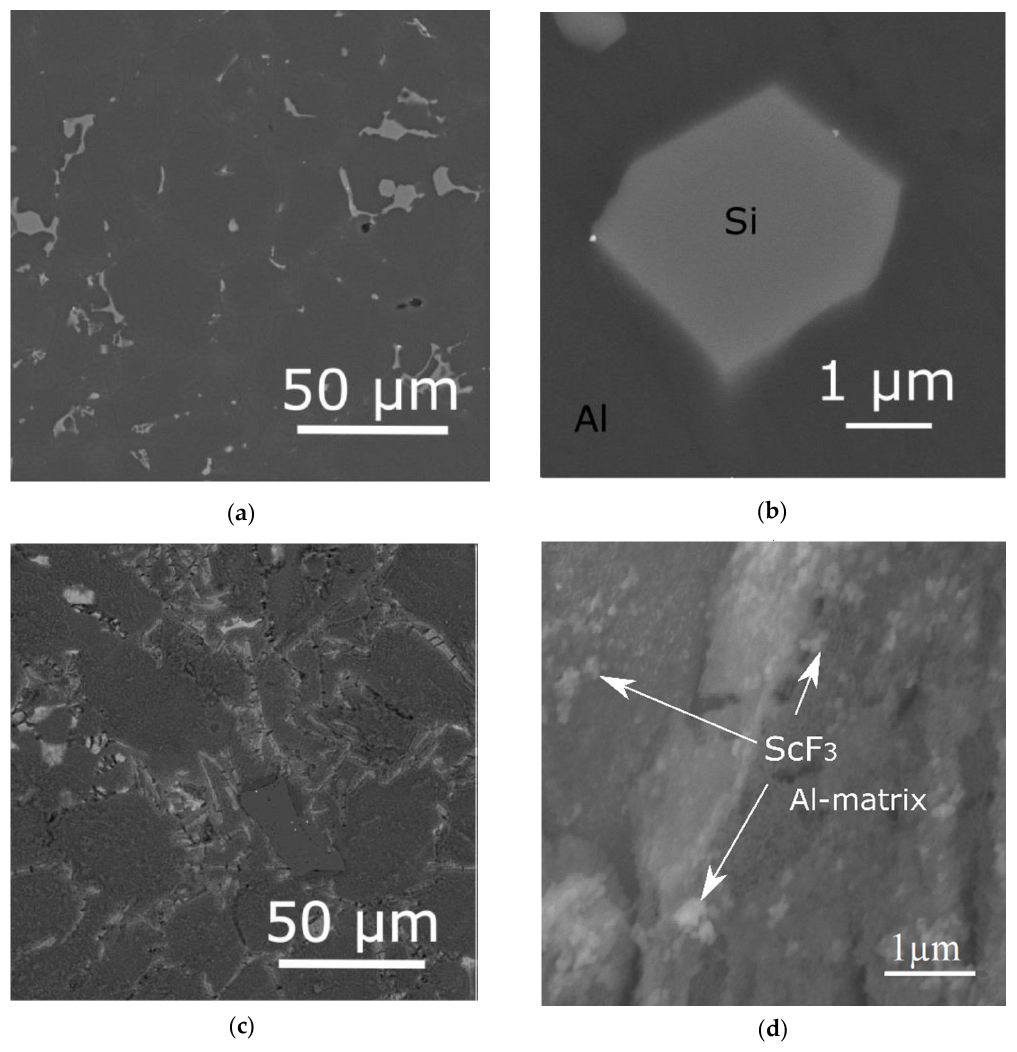
Figure 2. SEM images of the structure A356 alloys ( a , b ) and A356–1% ScF 3 ( c , d ). The microstructures of the initial aluminum alloy A356, A356 + 0.2% ScF 3 , and A356 + 1% ScF 3 are shown in Figure 3. It can be seen that the introduction of 0.2% ScF 3 nanoparticles into the aluminum alloy led to a decrease in the average grain size from 310 to 190 µ m. An increase in the amount of nanoparticles in the A356 alloy to 1% led to a decrease in the grain size to 100 µ m. obtained at room temperature ( T room = 293